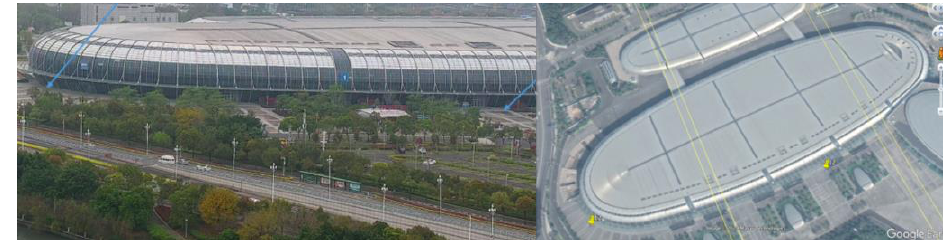
Figure 11. Scene A acquisition of control points.